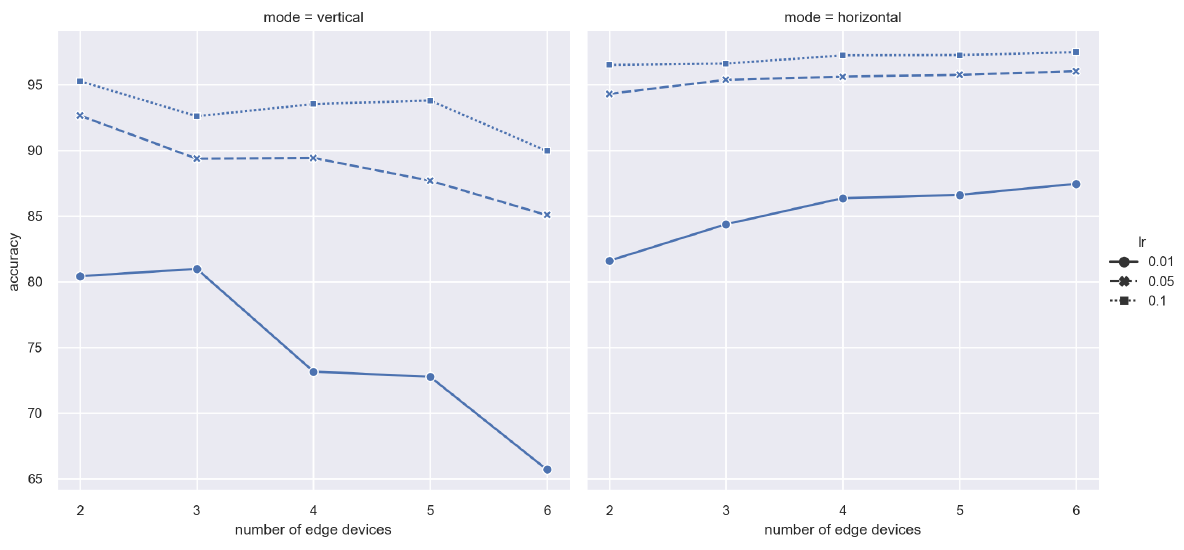
Figure 3. Accuracy vs. number of Edge devices.